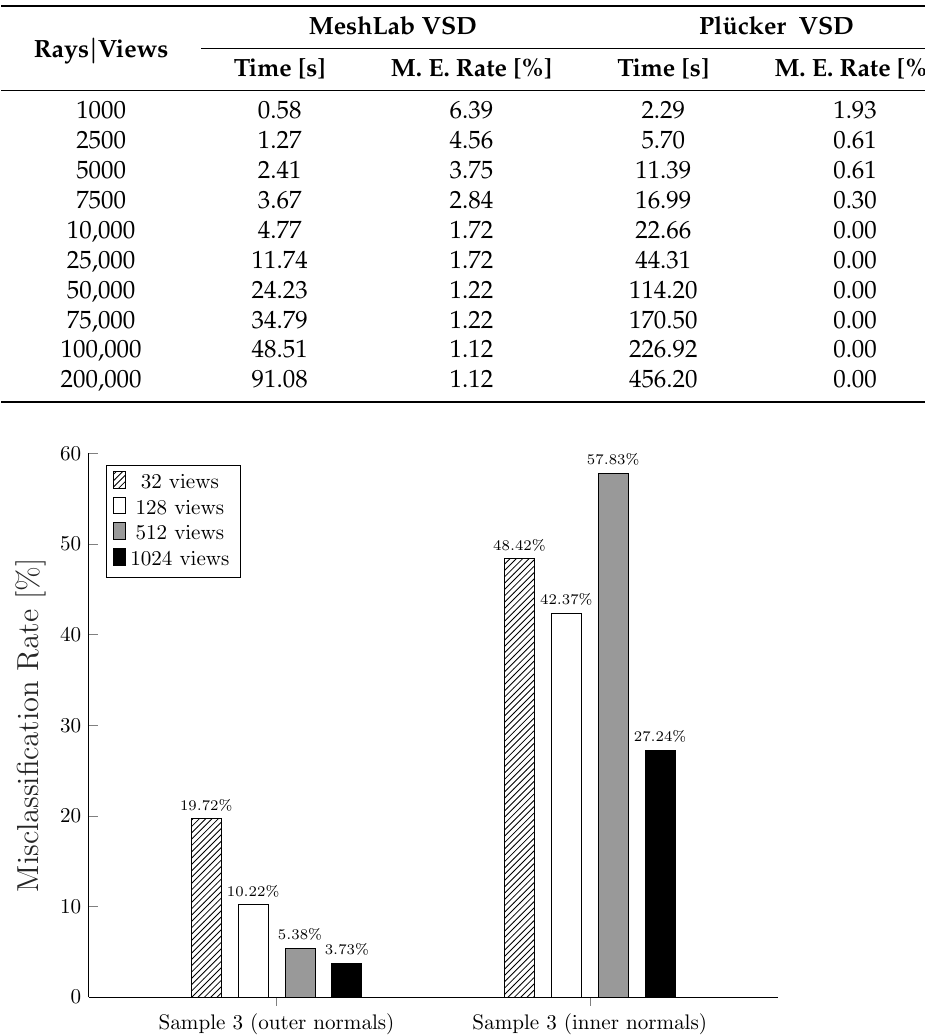
Figure 19. Misclassification rates comparison using MeshLab VSD algorithm on Sample 3 with outer and inner